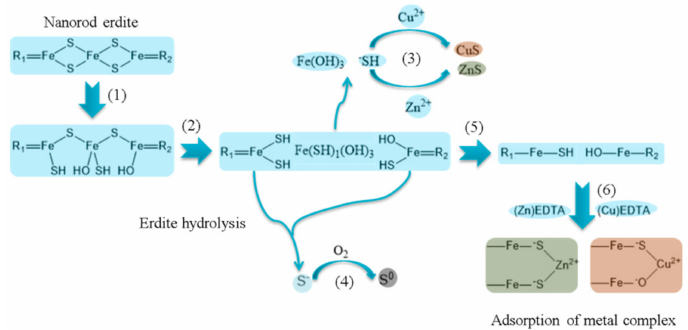
Figure 14. Illustration graph of SP2 for heavy metals removal from electroplating